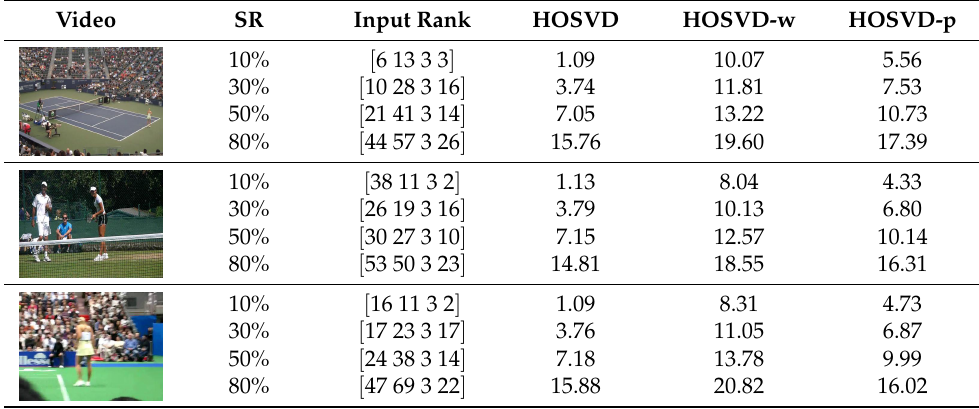
Table 2. Signal to noise ratio (SNR) for HOSVD and HOSVD-w on video data with non-uniform sampling